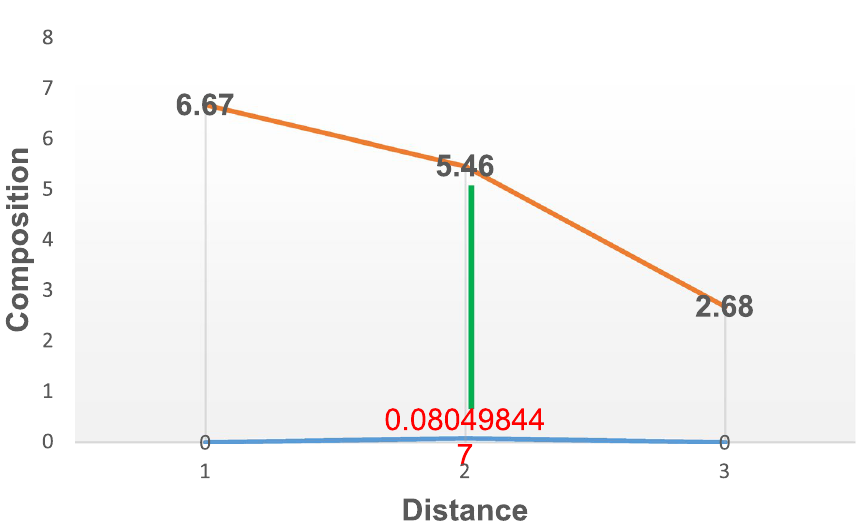
Figure 5. Diffusion of carbon atoms into the surface of grey cast iron at 900° for 150